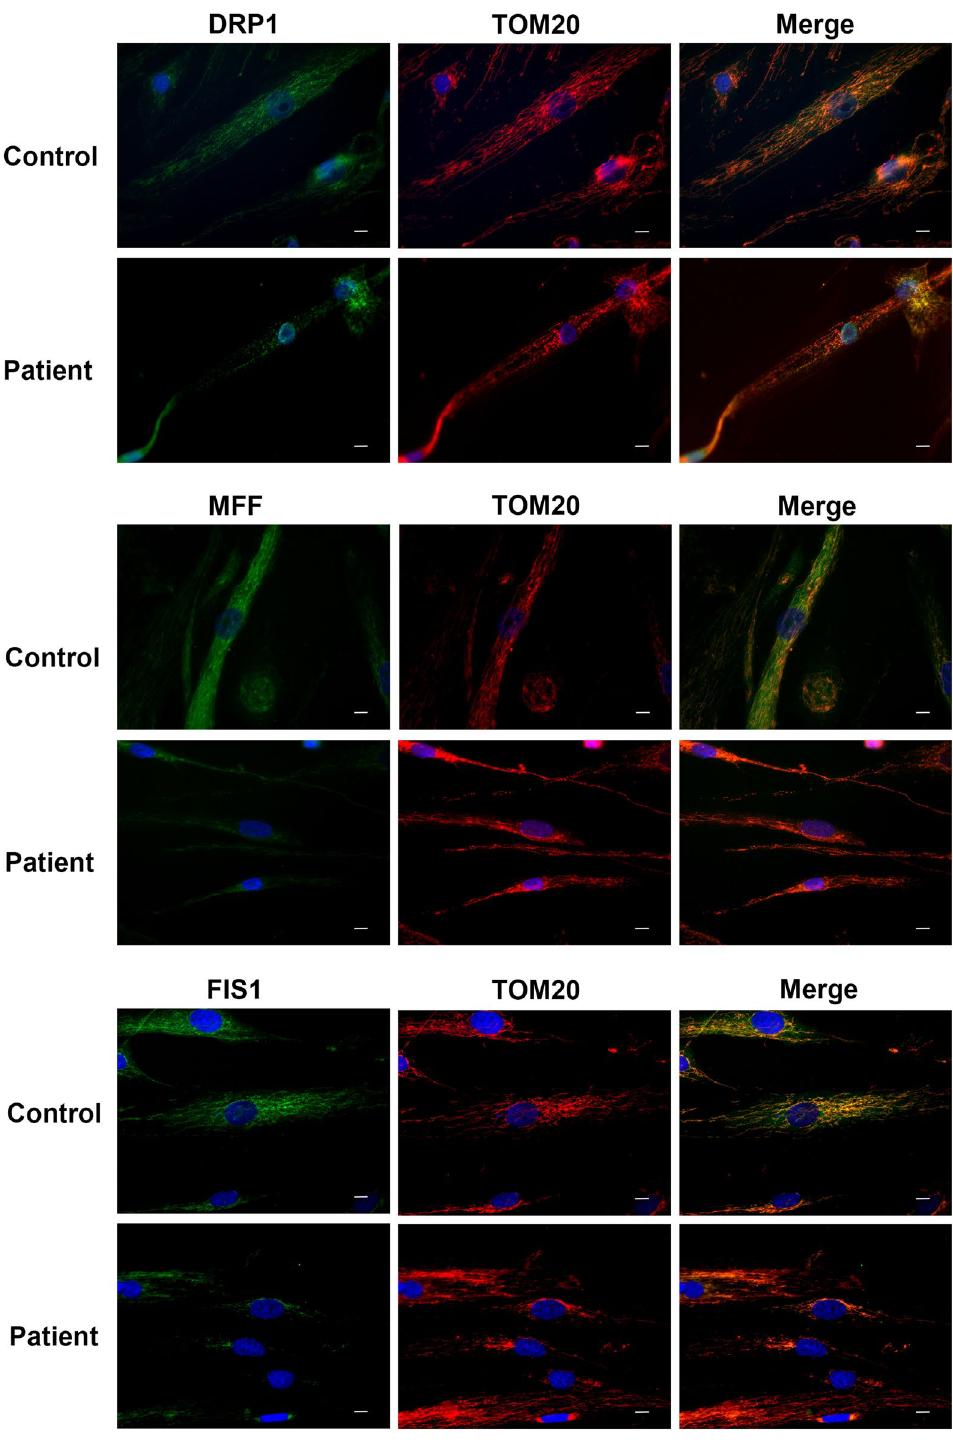
Figure 5. Immunofluorescence analysis of mitochondrial fission proteins in primary skeletal muscle cells of the Megaconial CMD patient. Left panel: Green/FITC: DRP1, MFF and FIS1 (top to bottom); Middle panel: Red/ Texas Red: TOM20/mitochondria; Right panel: Merged images, Blue: DAPI/nuclei. Scale bars: 10